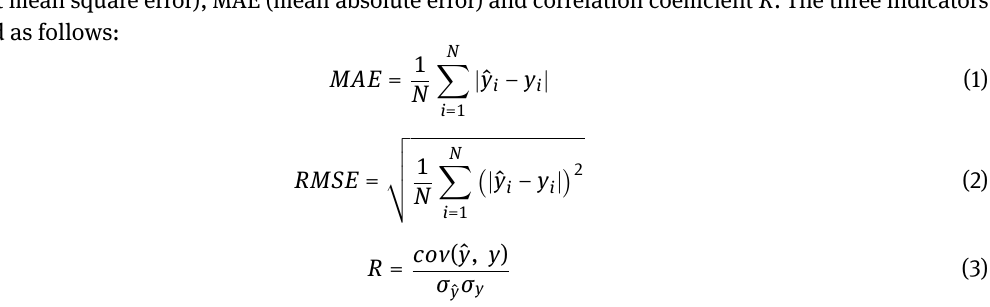
In equation (1) and (2), y i is actual output, ^ y i is the output generated through the algorithm and N is sample number in training